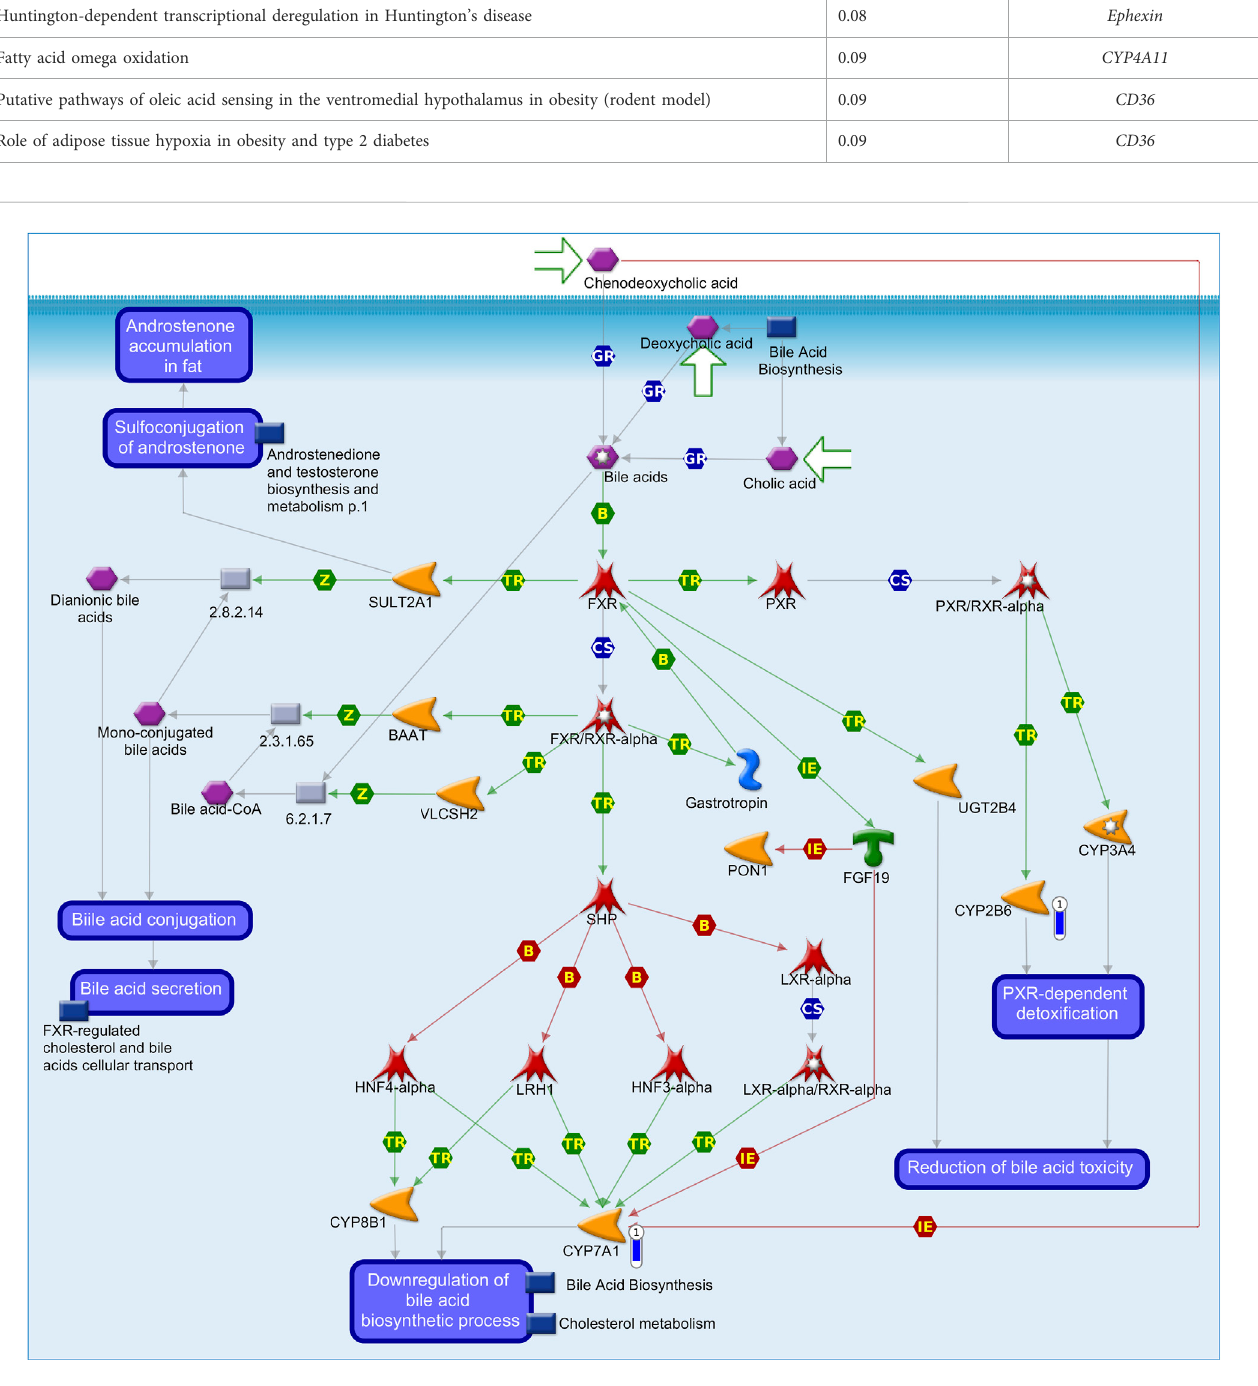
FIGURE 2 Pathway map representing the regulation of lipid metabolism_FXR-dependent negative feedback regulation of bile acid concentration using MetaCore software ( p -value < 0.10) based on the list ofdifferentially expressedgenes (FDR 10%) in theliver tissue ofpigs fedwith different oils inthediet(3.0% canola oil and 3.0% soybean oil). The blue thermometer indicates that the DEG is downregulated (log2-fold change − 2.31 and − 2.45) in the diet with 3.0% of canola oil (CO). Green arrows indicate positive interactions, and gray arrows indicate unspeci fi ed